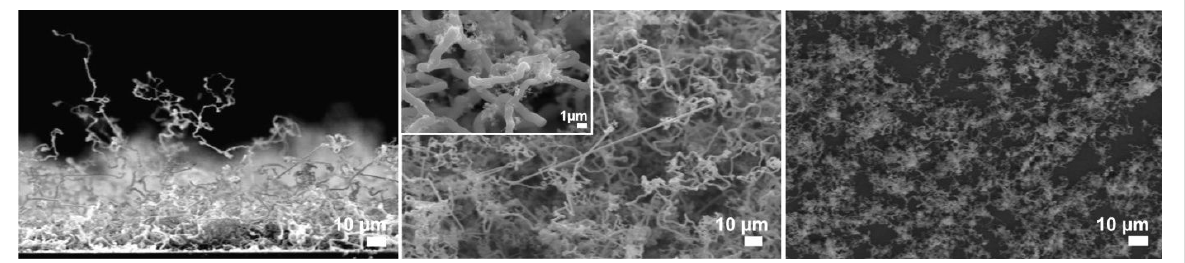
Figure 1: SEM images of NWs grown on gold-sputtered Si[111] exposed to NPS vapor at 375 °C for 1 h (left: side view; center: top view) and 30 min (right: top view). In the insert of the center view, the smaller, branching structures on the NWs become visible.